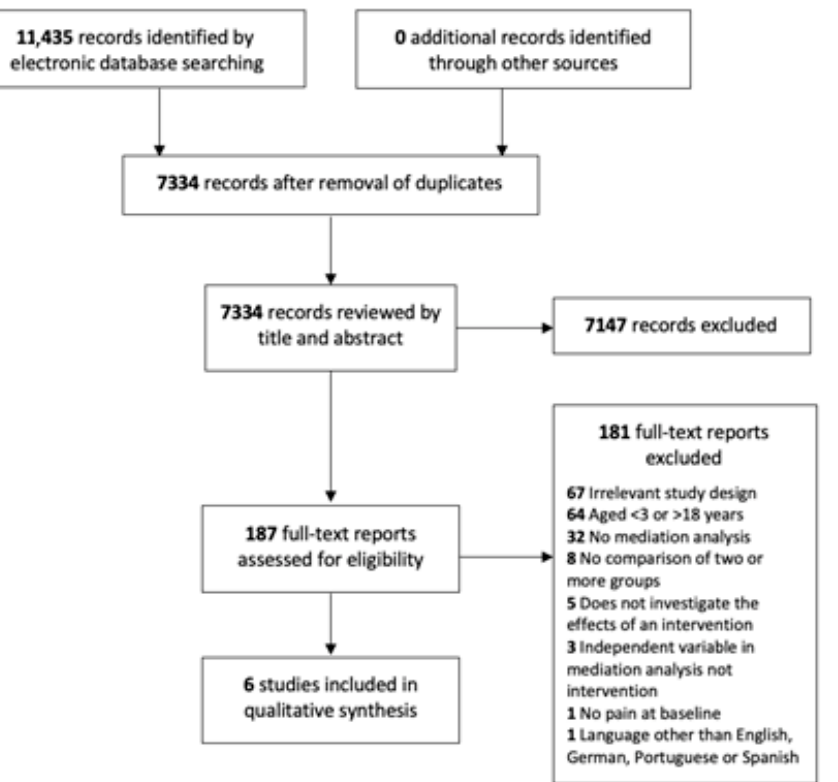
Figure 2. PRISMA flow diagram of the record selection process.